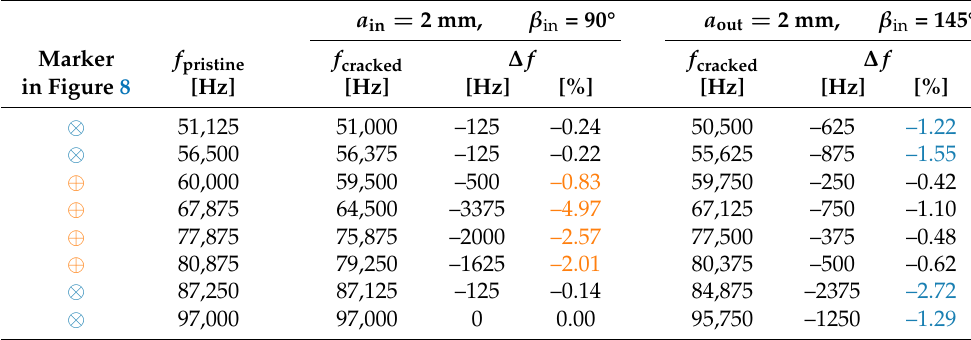
Table 2. Comparison of resonance frequencies in the conductance spectra G calculated with FEM for both crack locations. The relative shifts of resonance frequencies for each crack location are highlighted in orange and blue,